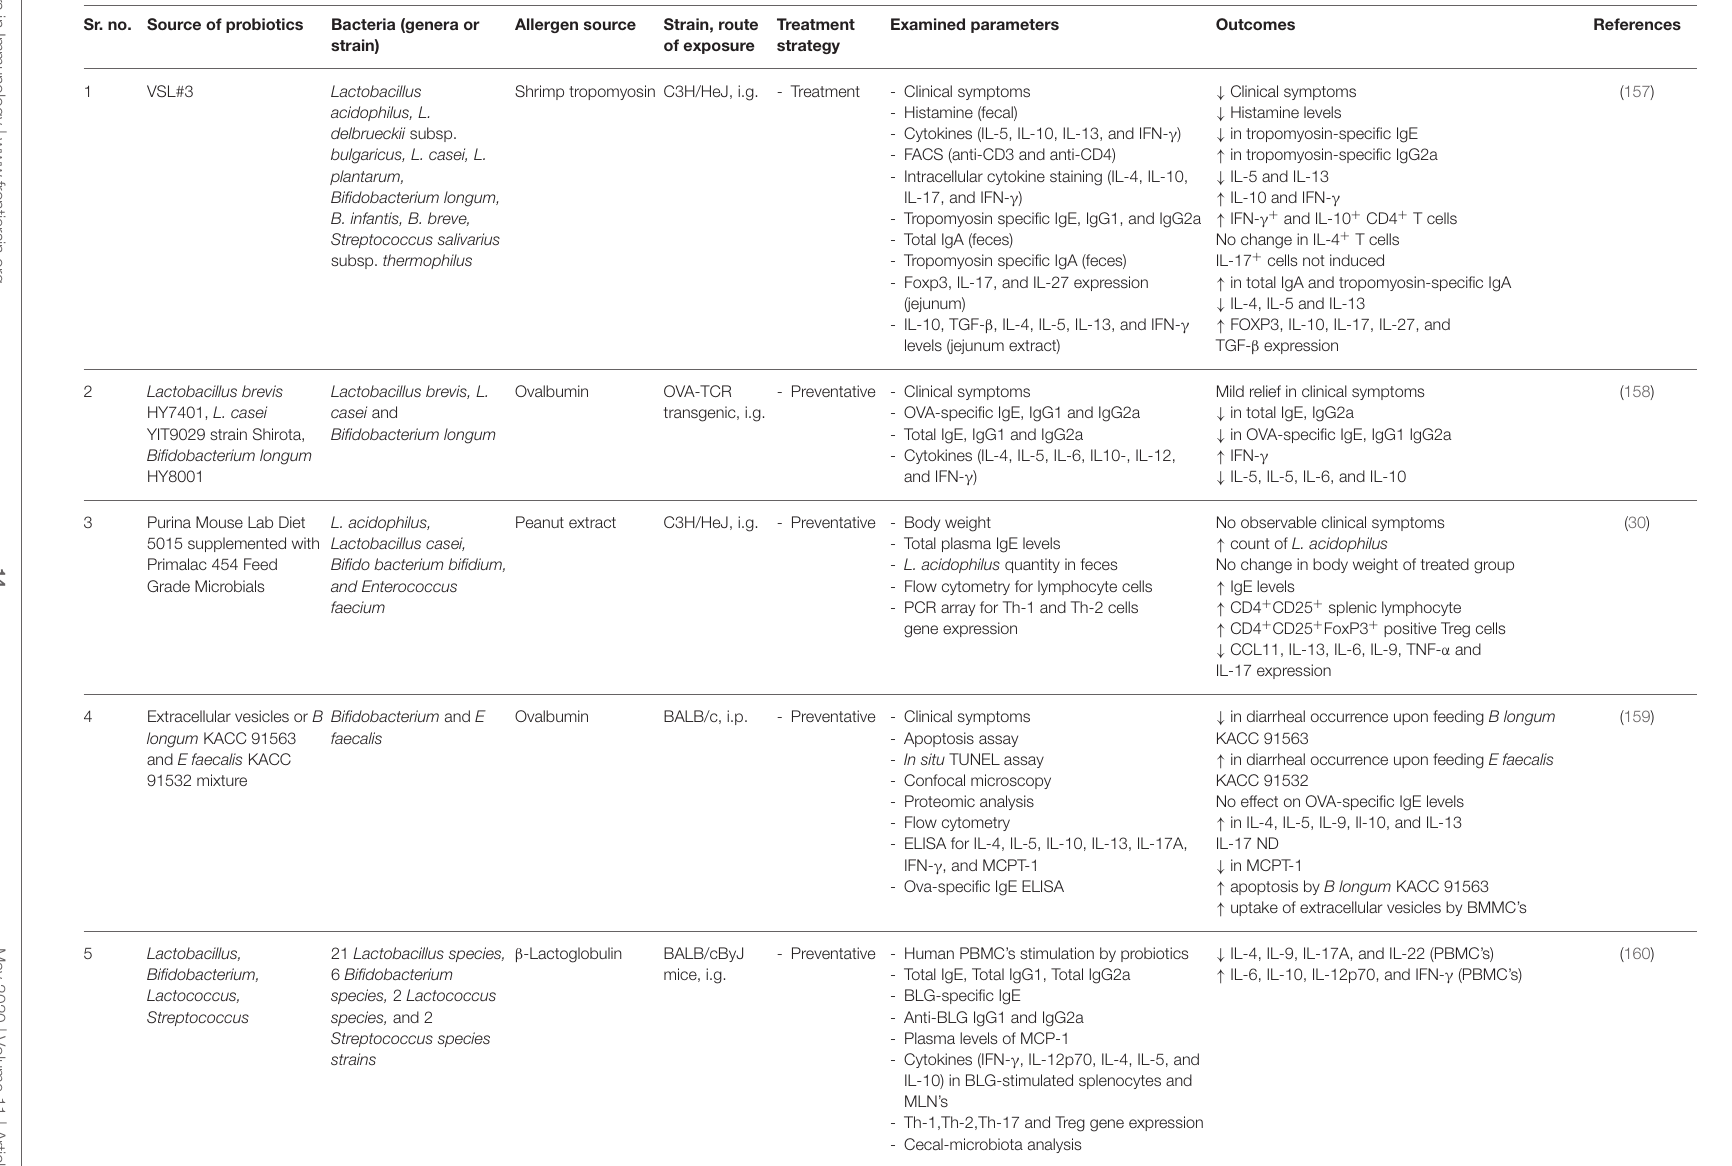
TABLE 3 | A summary of pre-clinical studies investigating the role of probiotics tested for preventative (prophylactic) or treatment (curative) strategies, in reducing the progression or clinical symptoms in various mouse models of food allergy. Sr. no. Source of